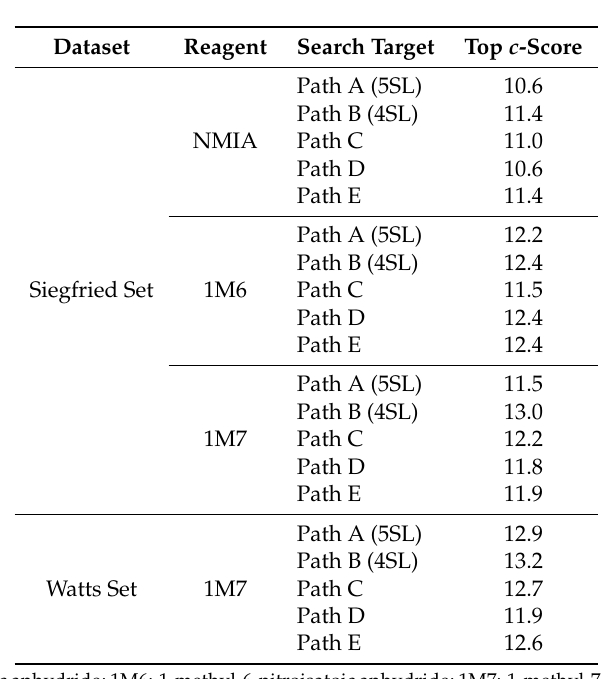
Table 1. Highest patteRNA scores when searching Rev response element (RRE) motifs across